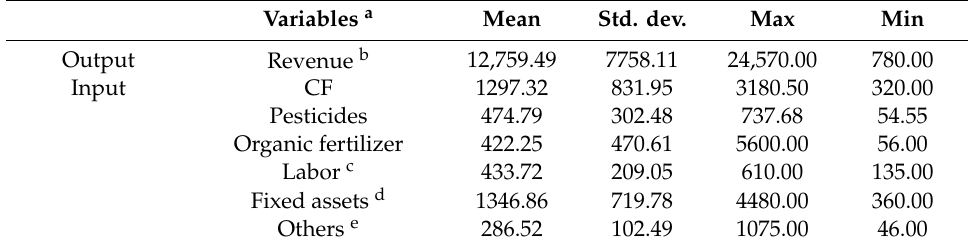
Table 3. Descriptive statistics of the input and output per mu (1 / 15 ha) of households growing grapes.